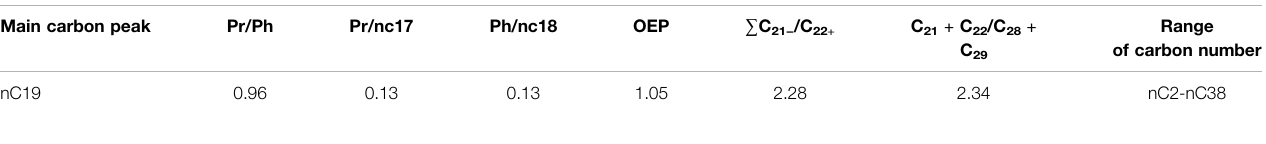
TABLE 1 | Analysis results of total hydrocarbon gas chromatography. Main carbon